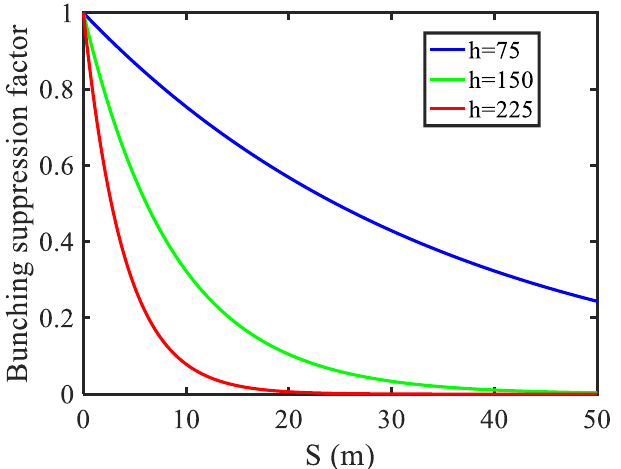
Figure 9. The bunching suppression factors as functions of the drift section length S for three differ- ent harmonics ( ℎ = 75 (blue), ℎ = 150 (green), ℎ = 225 (red)). harmonics ( h = 75 (blue), h = 150 (green), h = 225